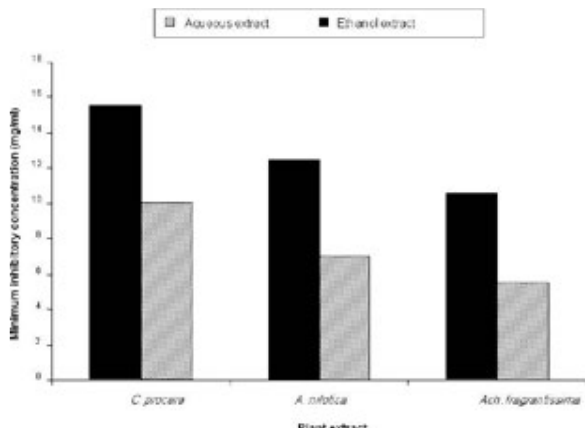
Figure 3. Minimum inhibitory concentrations (mg mL -1 ) of the tested plant extracts.